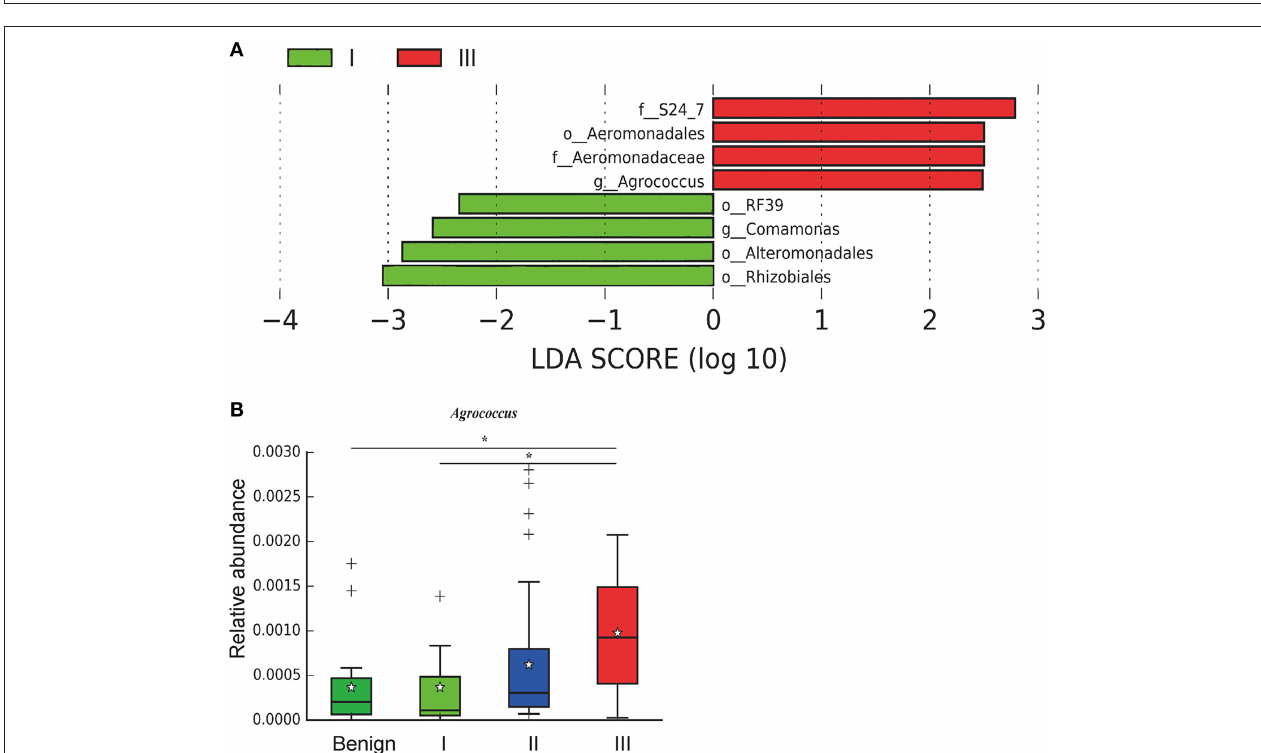
FIGURE 6 | Barplots of the taxonomic profiles of the grade I, II and III breast tumor tissue microbiota. (A) Phylum level. (B) Family level.